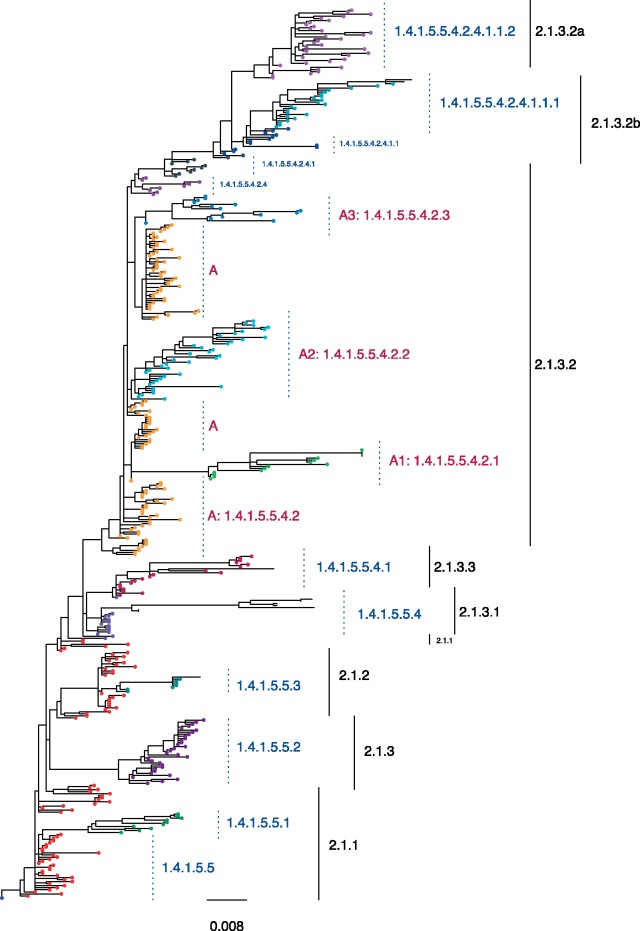
Phylogeny of the Clade 2.1x viruses circulating in Indonesia. The WHO/OIE/FAO H5 nomenclature is annotated in black. PhyCLIP’s cluster designation is indicated in blue, corresponding to tip color. PhyCLIP’s supercluster topology is exemplified by Cluster A. The source population of the supercluster is annotated as A in pink, with tips colored yellow. The divergent descendant clusters are annotated as A.1, A.2, and A.3 respectively here. The letter A here is shorthand for its nomenclature address, 1.4.1.5.5.4.2. This nomenclature address indicates that supercluster A is the second descendant of cluster 1.4.1.5.5.4 (indicated in light purple), which in turn is the forth descendant of the source supercluster 1.4.1.5.5, indicated in red. See “Materials and Methods” section for full explanation of nomenclature addresses.